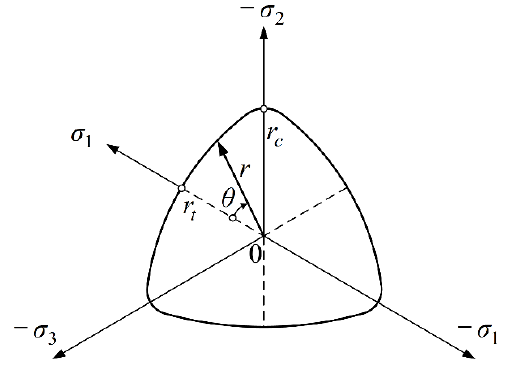
Figure 7. Deviatoric section of the Willam–Warnke failure surface.